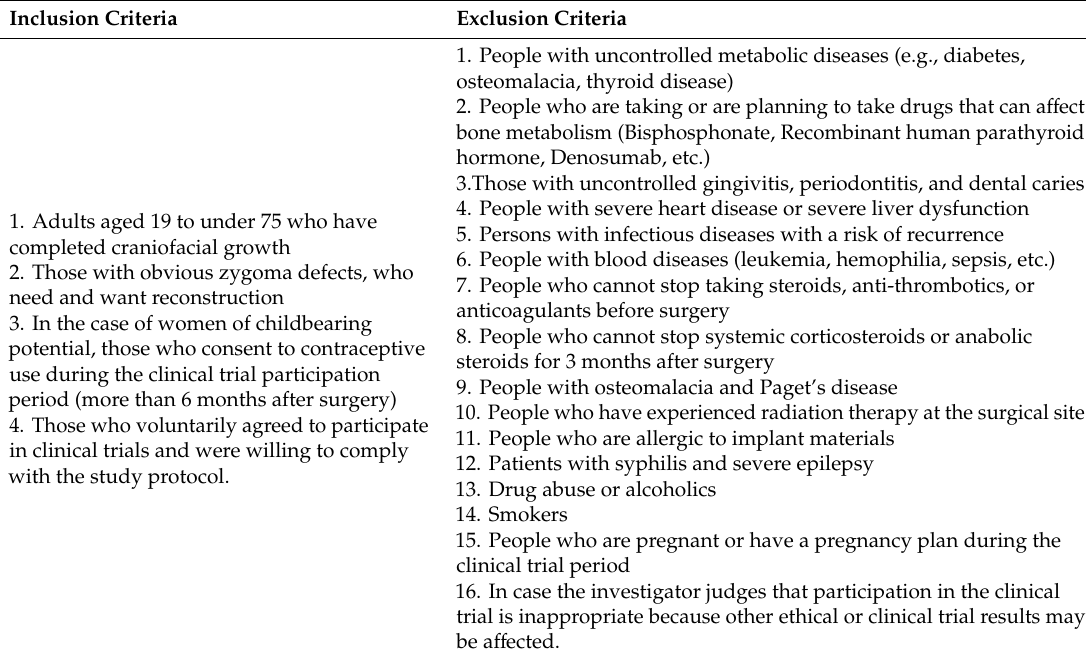
Table 1. The inclusion criteria and exclusion criteria of this